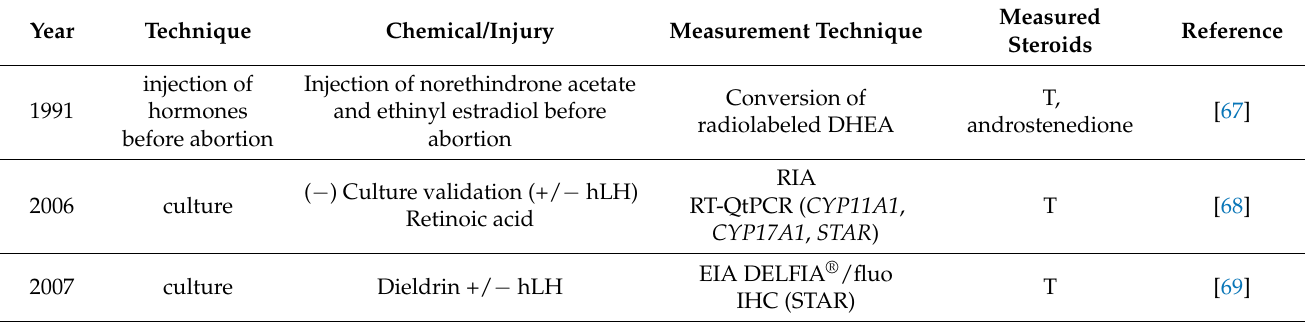
Table 2. Steroid measurements in ex vivo studies. Pregnenolone (Preg); 17-hydroxy-pregnenolone (17OH-Preg); Proges- terone (P4); 17-hydroxy-progesterone (17OH-P4); dehydroepiandrosterone (DHEA); androstenedione; testosterone (T); 5 α -dihydrotestosterone (DHT); estrone (E1); human chorionic gonadotrophin (hCG); human luteinizing hormone